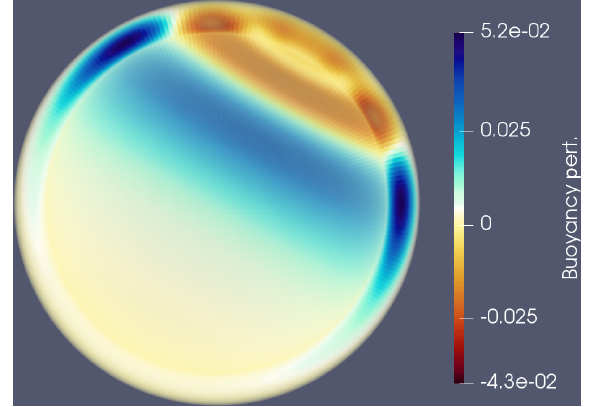
Figure 7. Buoyancy perturbation ( y − z cross section) at t = 3600s from a simple gravity wave test ( (cid:49)t = 100s). The initial conditions (in lat–long coordinates) for the velocity are a simple solid-body rotation: u = 20 e λ , where e λ is the unit vector pointing in the di- rection of decreasing longitude. A buoyancy anomaly is defined 2 via b = d sin (πz/ 10000 ) , where q = R cos − 1 ( cos (φ) cos (λ − d 2 + q 2 λ φ )) , d = 5000m, R = 6371km / 125 is the planet radius, and λ φ = 2 / 3. The equations are discretized using the lowest-order method RTCF 1 , with 24576 quadrilateral cells in the horizontal and 64 extrusion levels. The velocity–pressure system is solved using hy-